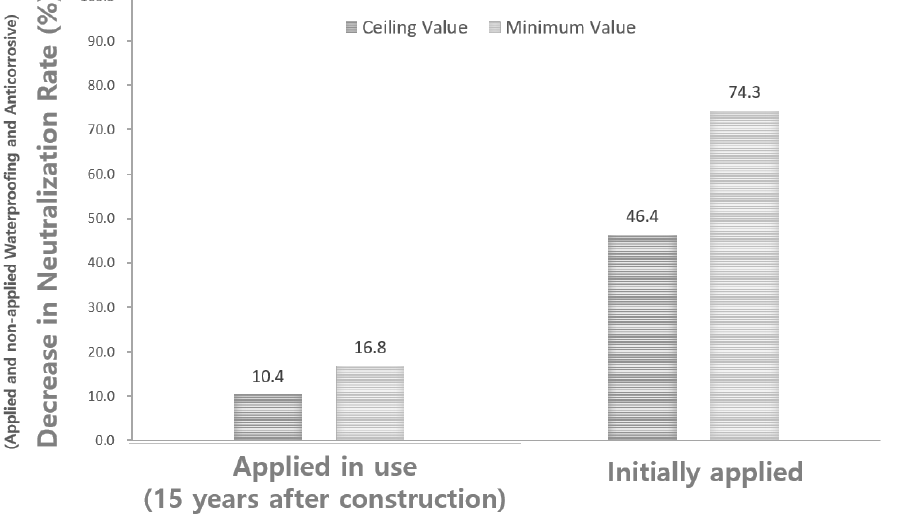
Figure 13. Comparison of rates of decrease in carbonation rates according to the duration of the waterproofing/anticorrosive method application.